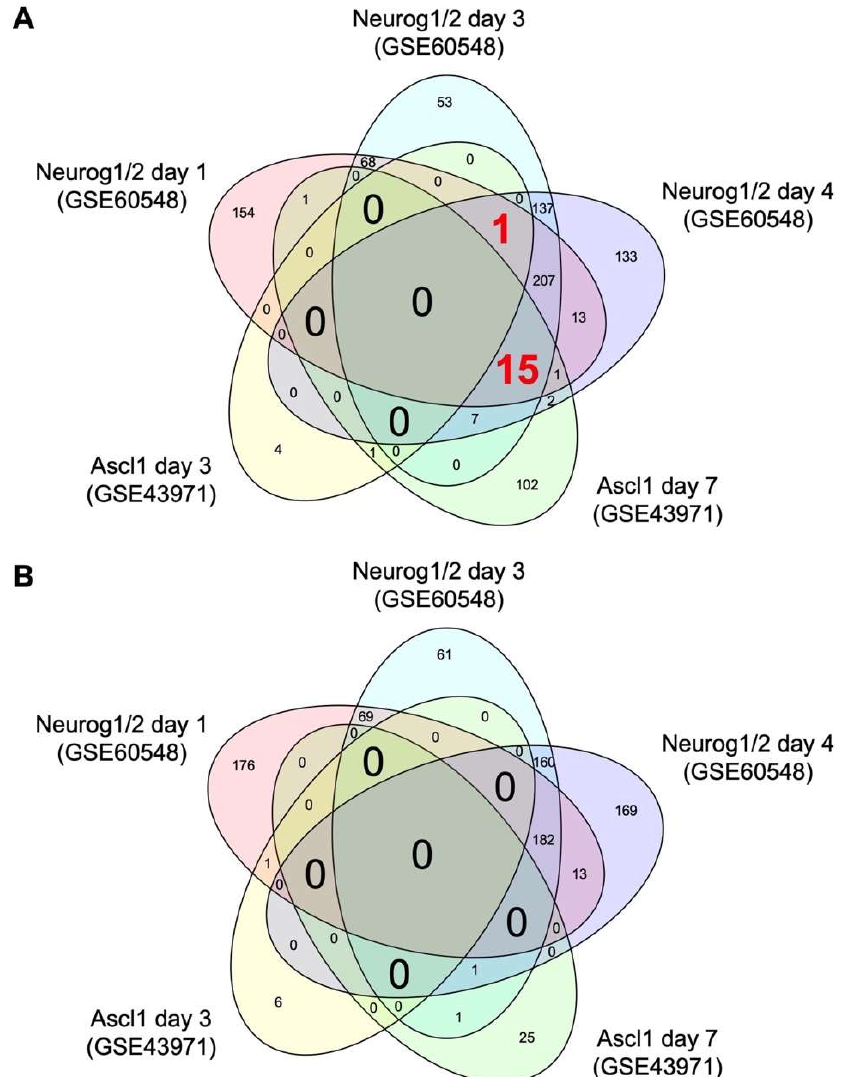
Figure 1. Venn diagrams of the number of differentially expressed genes regulated by Neurog1/2 and Ascl1. Transcriptome data of stem cells with and without overexpression of Neurog1/2 (GSE60548) or Ascl1 (GSE43971) were downloaded from a public database. Genes differentially expressed in stem cells on days 1, 3, and 4 post-induction of Neurog1/2 overexpression versus control cells, or on days 3 and 7 post-induction of Ascl1 overexpression versus control cells were identified using a false discovery rate threshold of 10%. The number of genes increased ( A ) and decreased ( B ) by Neurog1/2 or Ascl1 in each group and the overlap between groups are shown.